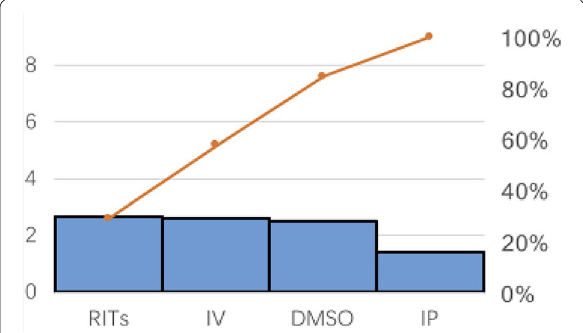
Figure 12 Contributions of the significant factors on MTD